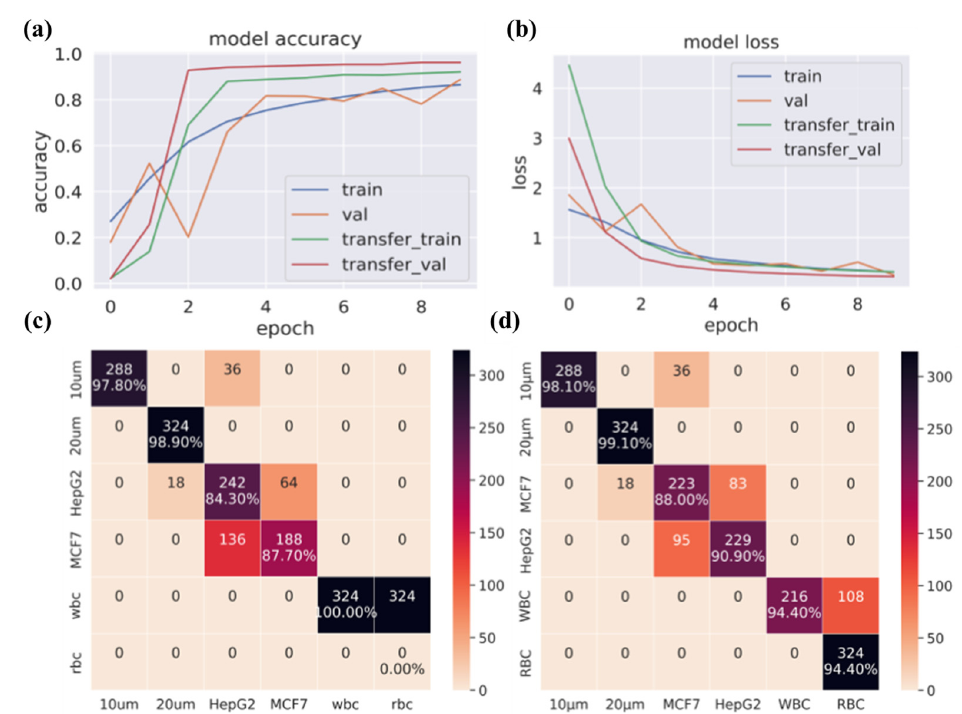
Figure 6. The results from the transfer of learning study. ( a ) Epoch vs. accuracy graph for the initial epochs in the initial training phase without RBC and then the transfer of training with RBC. The blue and saffron colors represent the initial training accuracy and validation curves. The green and red lines represent the transfer learning accuracy and validation curves, ( b ) epoch vs. loss, ( c ) the confusion matrix from the pre-trained model, and ( d ) the confusion matrix with the re-trained model.